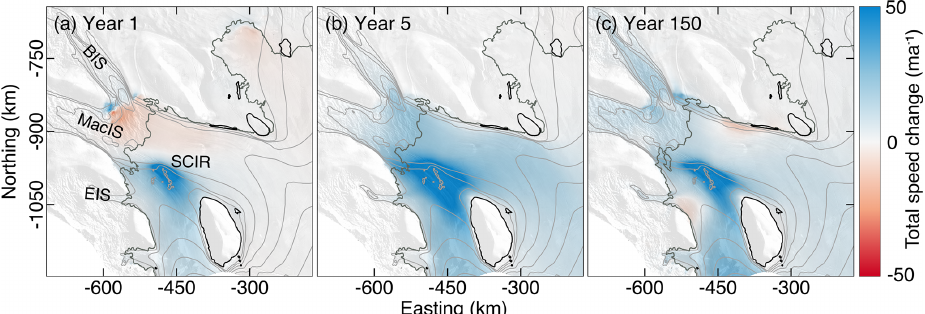
Figure 9. The total difference in ice speed between the steady state, B inv reference model (with SCIR) and the perturbed model (without SCIR) at various model time steps following removal of the SCIR. Panel (a) is the instantaneous response, and panels (b) and (c) demonstrate the longer timescale adjustment of the ice-shelf and ice-stream system. Positive values indicate faster flow for the perturbed model without the SCIR, and negative values indicate slower flow. By a time step of 150 years, the model has reached a new steady state. Grounding-line positions are from the perturbed model at time steps of 1, 5 and 150 years. The velocity contour lines have an interval of 100ma − 1